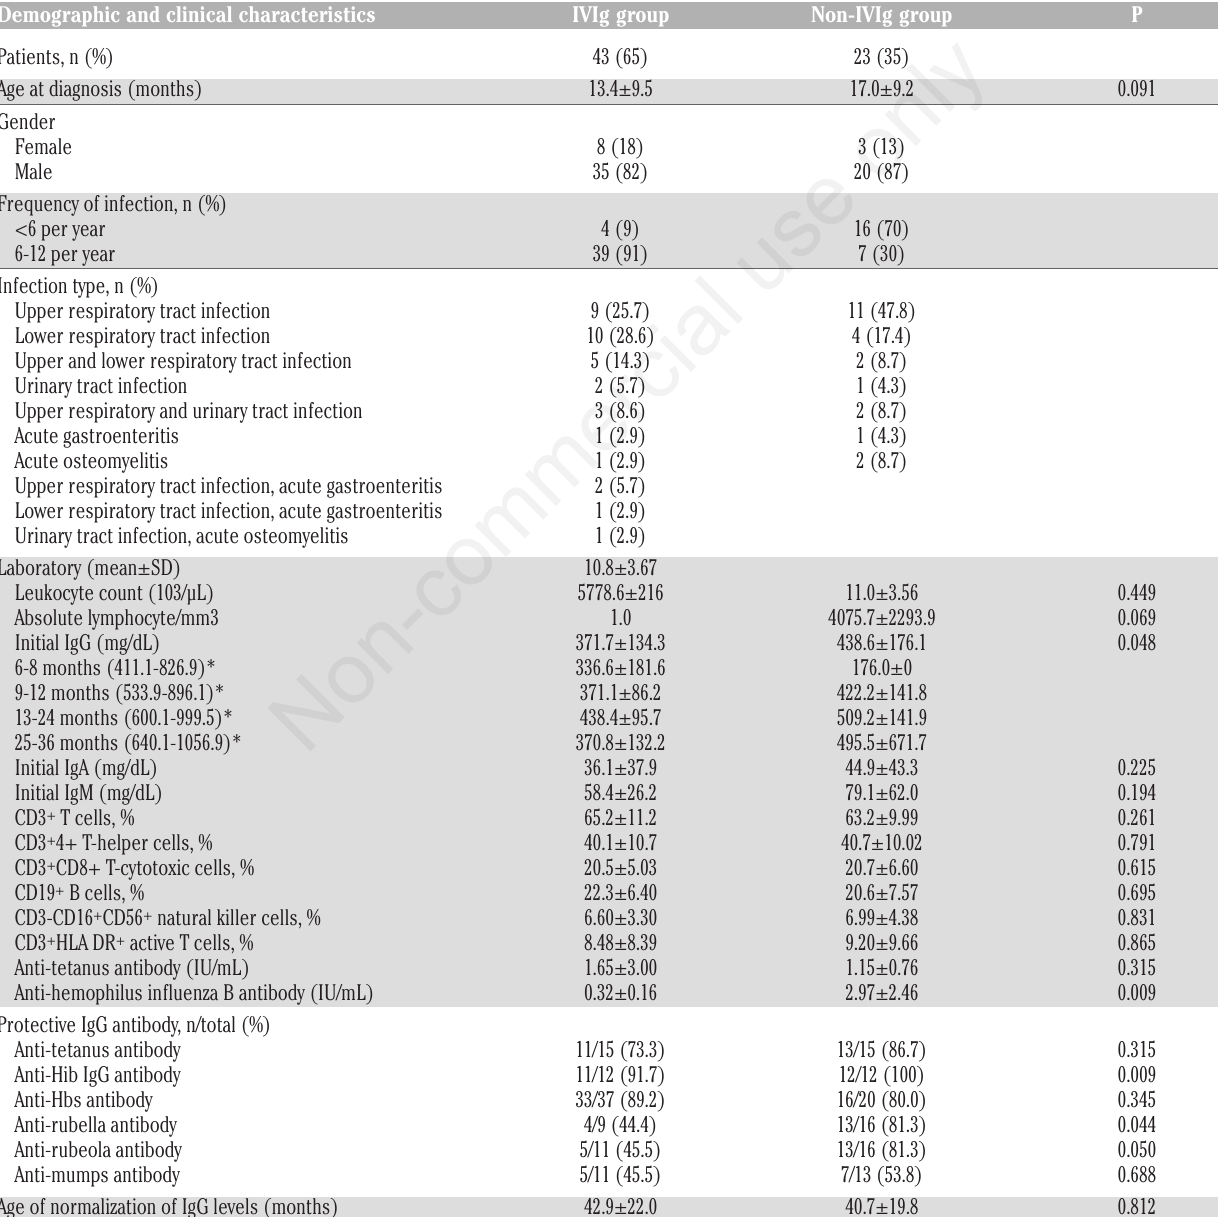
Table 1. Demographic and clinical characteristics and laboratory data of transient hypogammaglobulinemia of pediatric patients who were treated and were not treated with intravenous immunoglobulin. In the intravenous immunoglobulin group, antibody levels were determined before intravenous immunoglobulin